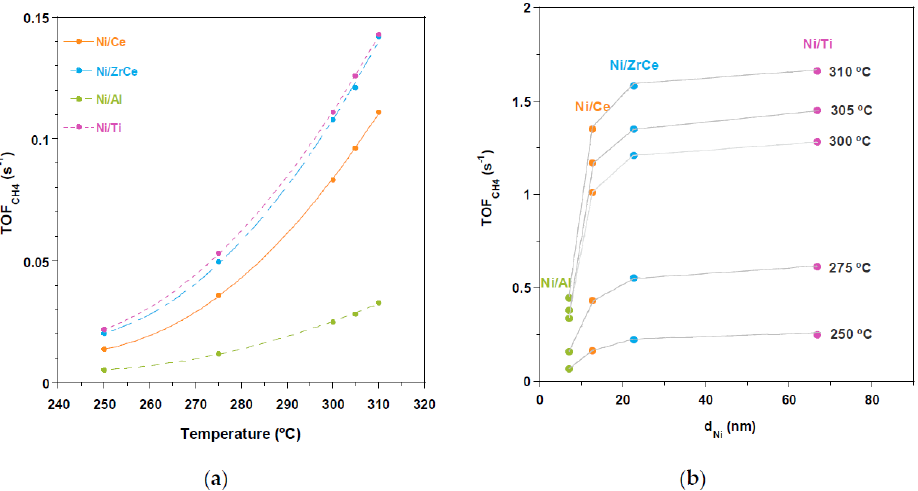
Figure 6. Turnover frequencies of CH 4 formation as functions of the reaction temperature ( a ). Mean metallic Ni particle size derived from CO chemisorption measurements ( b ).